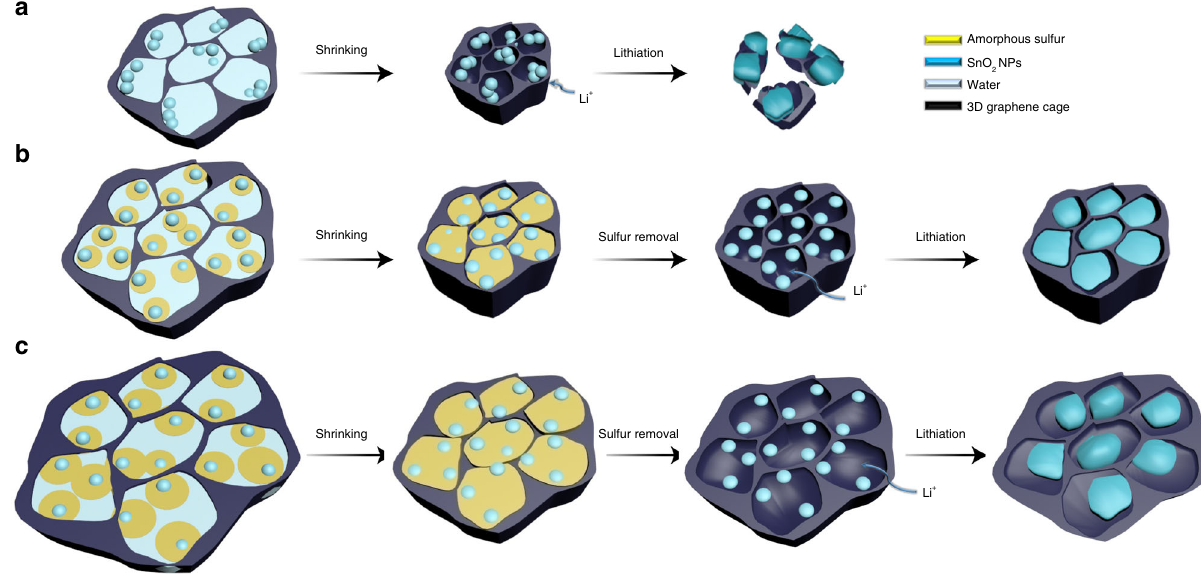
Fig. 1 Sulfur template control of incorporated void space. a Schematic of the limited space produced after the shrinkage of a 3D graphene assembly, leading to cracking of the graphene cage and electrode pulverization when the SnO 2 expands during the lithium storage process. b When an appropriate amount of sulfur is used as a sacri fi cial template for incorporating void space, the SnO 2 has enough space for lithiation. Note that sulfur removal could result in the production of the smallest suf fi cient void space, thus achieving high volumetric performance. c The removal of excess sulfur would introduce a large